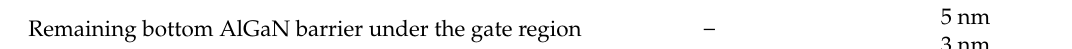
Table 1. Summary of the Varied Parameters.